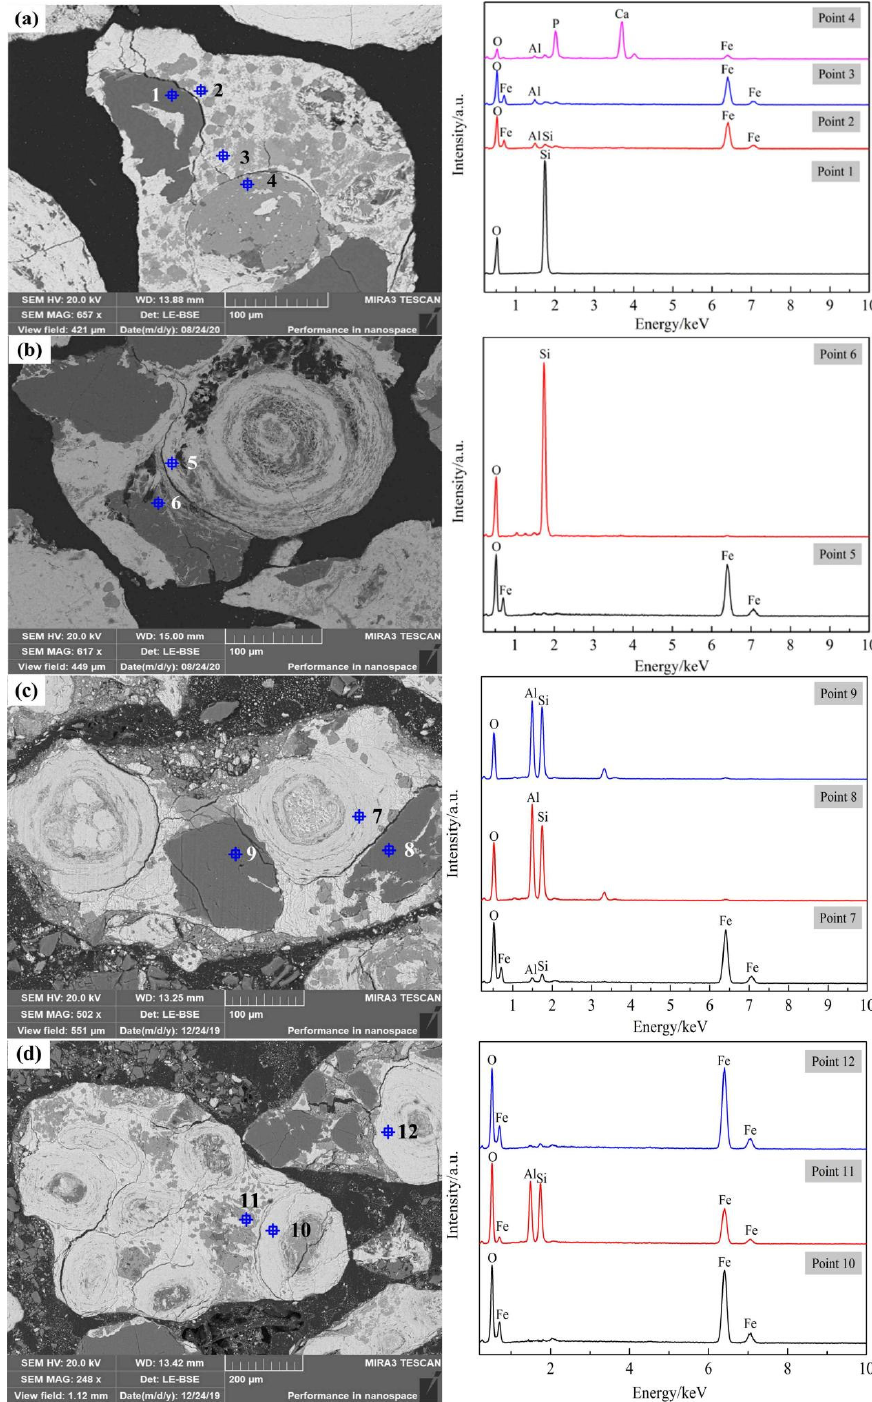
Figure 9. SEM images and EDS spectra of products with different roasting times, and with a roasting temperature of 650 °C: ( a ) 2 min, ( b ) 3 min, ( c ) 4 min, ( d ) 5 min.